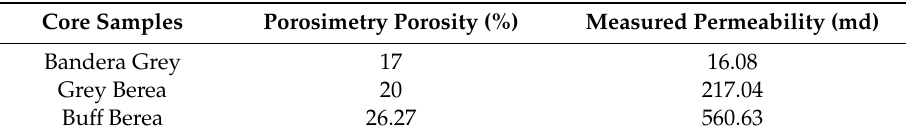
Table 2. Measured petrophysical